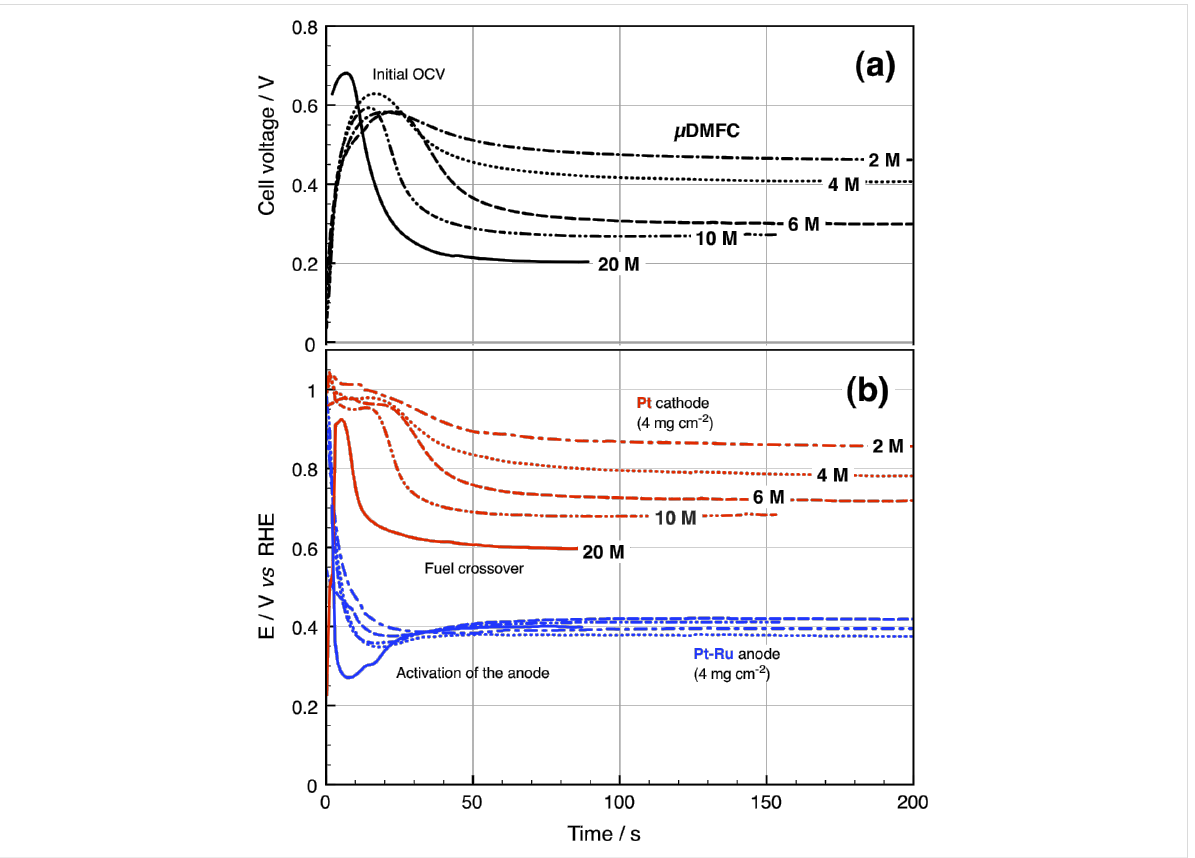
Figure 2: (a) Cell voltage and (b) electrode potential stabilization as 100 µL of CH 3 OH at a given concentration, was added into the fuel